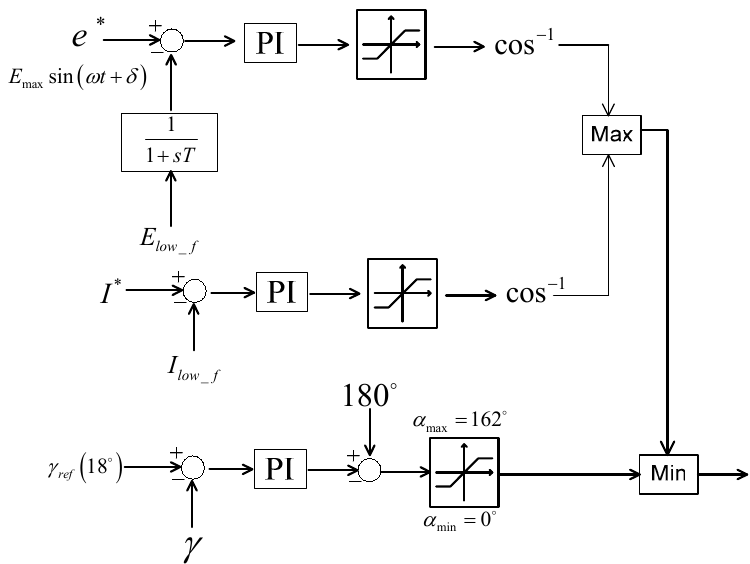
Figure 11. Control scheme of LFAC transmission system.